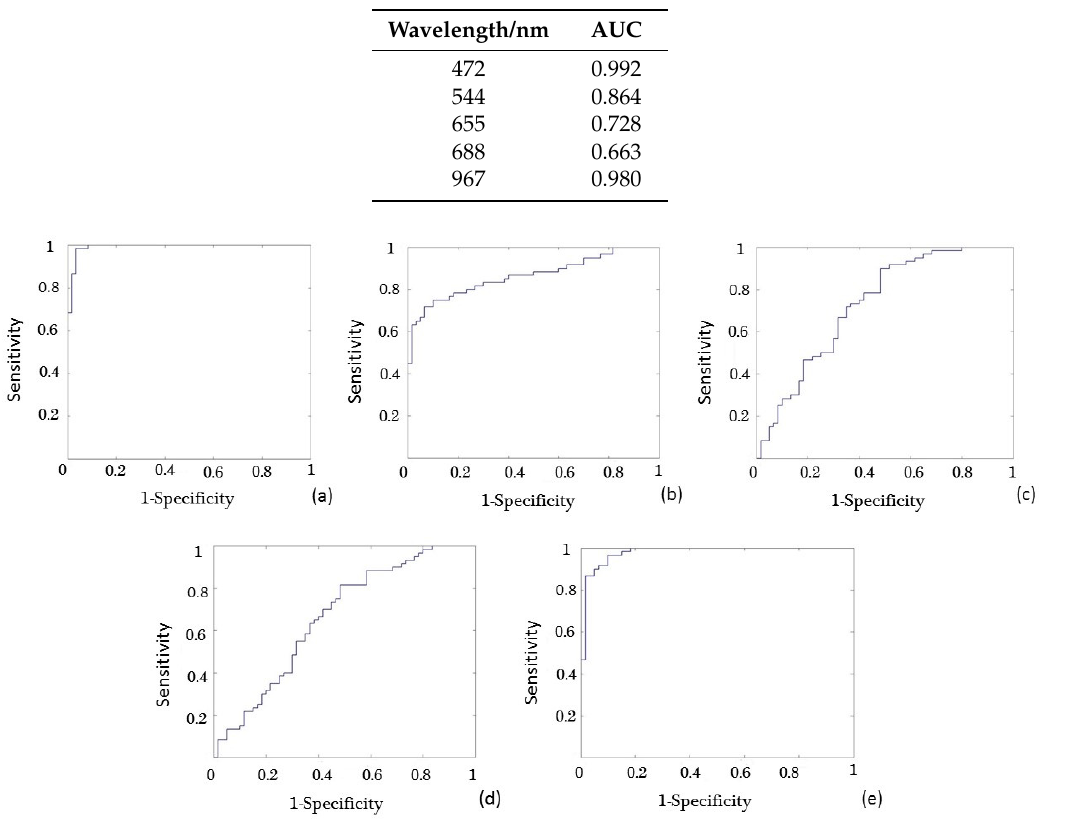
Figure 6. The receiver operating characteristic (ROC) curves at different wavelengths of modeling samples: ( a ) 472 nm; ( b ) 544 nm; ( c ) 655 nm; ( d ) 688 nm; ( e ) 967 nm.